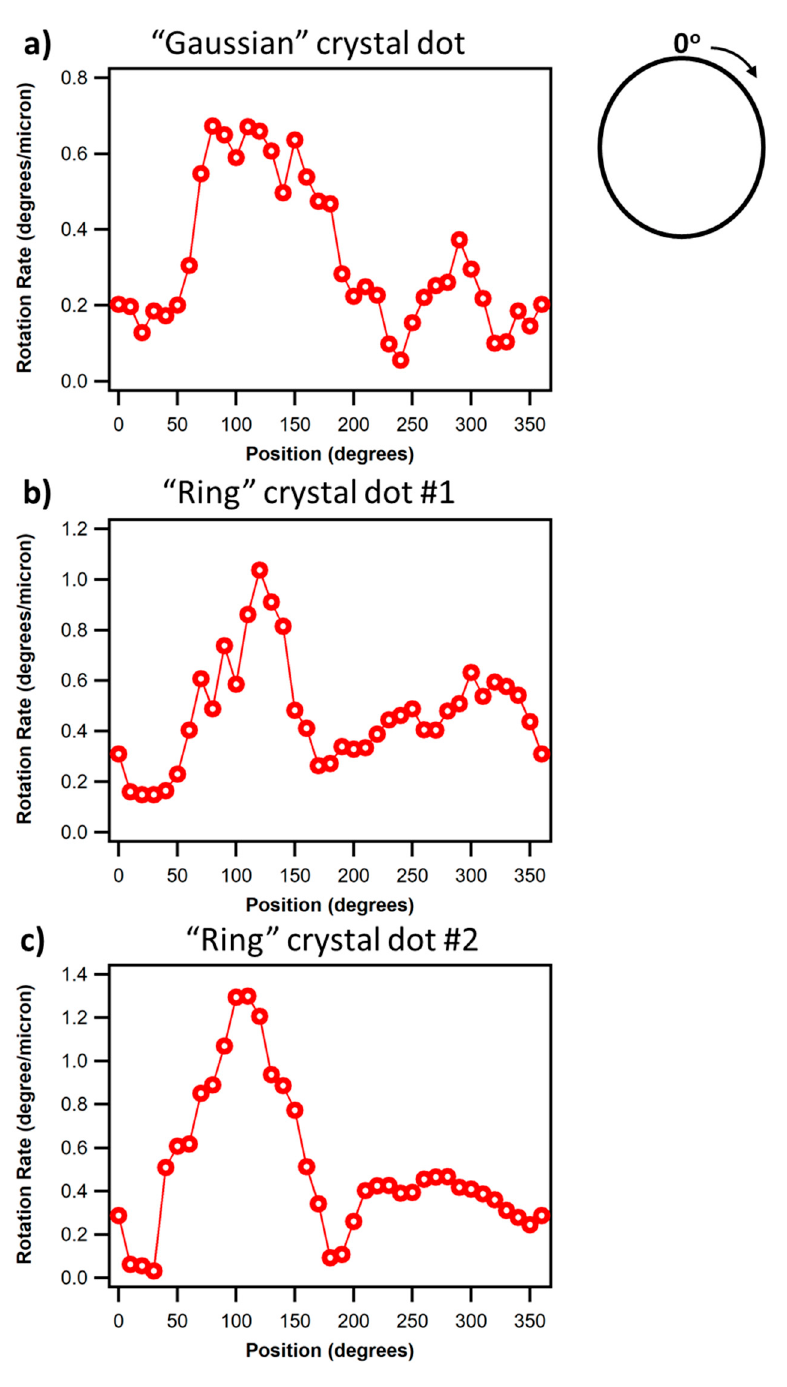
Figure 6. Graphs representing the rotation rate with respect to the position from the center to the periphery of the dot for ( a ) the “Gaussian” dot, and “ring” crystals #1 ( b ) and #2 ( c ). Here, 0 o corresponds to the top of the crystal dot (as identified by the arrow in Figures 1,4 and 5) and increases clockwise around the crystal structure, as seen in the schematic to the right.